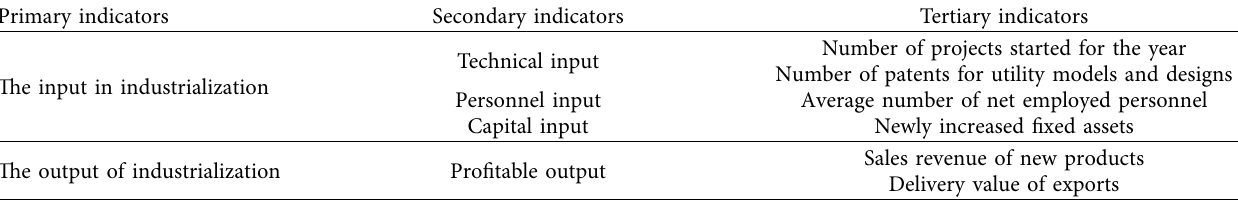
Table 3: Indicator system of industrialization stage.